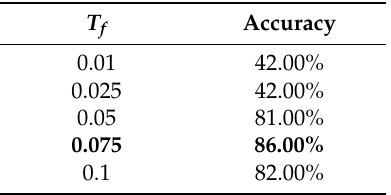
Table 5. Accuracies corresponding to each T f .